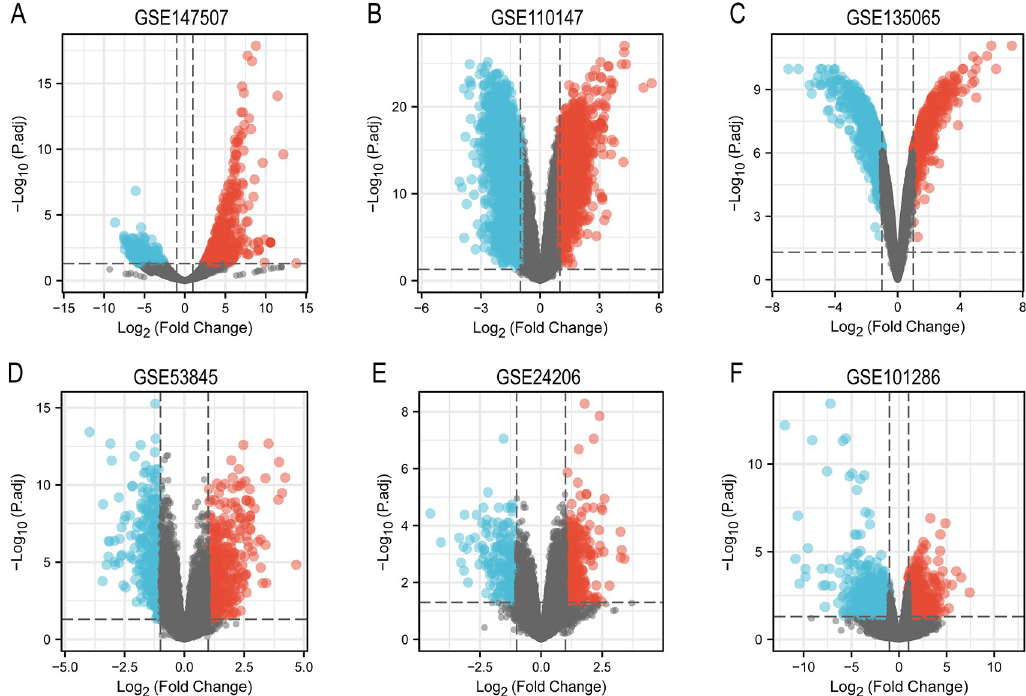
Fig 2. Volcano plot of differentially expressed gene from COVID-19 patient samples and IPF patient samples. A: Volcano plot of differentially expressed genes between uninfected human lung biopsies and that of deceased COVID-19 patient. B-F: Volcano plot of differentially expressed genes between lung samples from IPF patients and healthy control. The red plots with | log FC| > 1 and P value < 0.05 represent upregulated genes and blue represents downregulated genes.